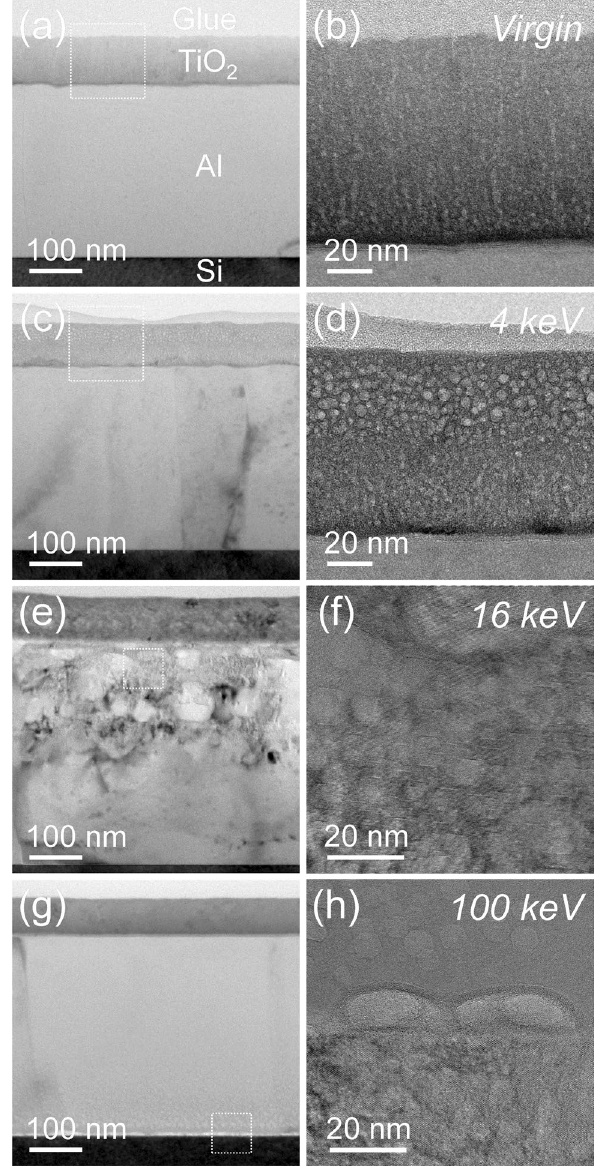
Figure 5. Cross-sectional TEM bright-field images ( a , c , e , g ) of the reference sample and the irradiated samples at 4 keV, 16 keV, and 100 keV, respectively as well as higher magnified ( b , d ) and high-resolution TEM images ( f , h ) for the areas marked in the corresponding overview images on the left